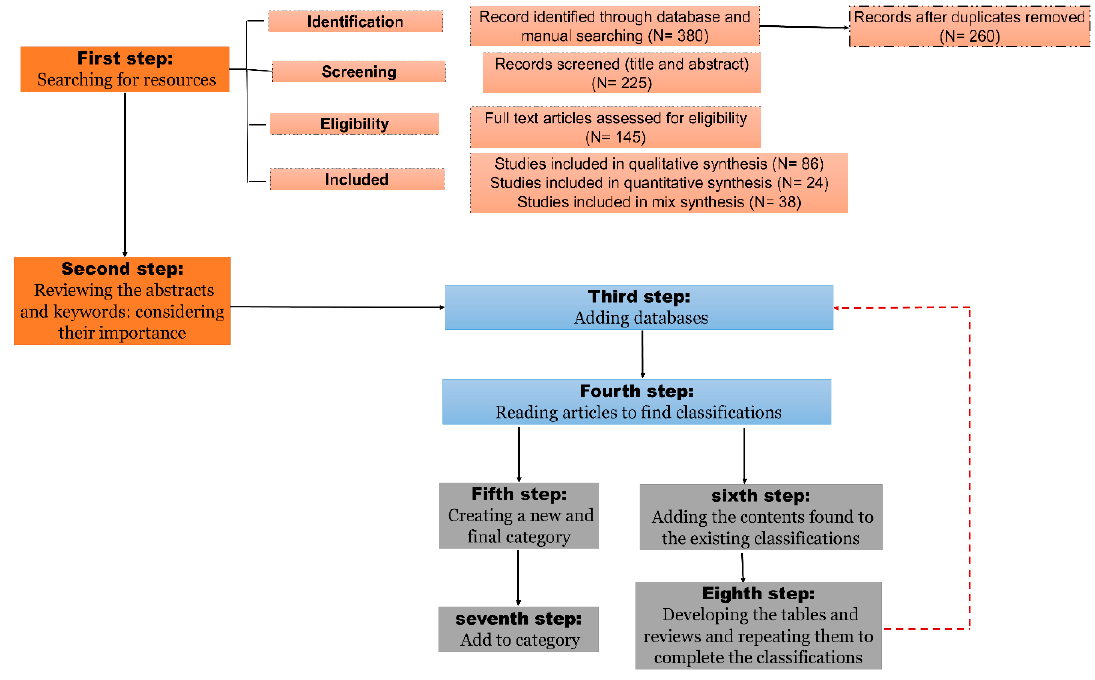
Figure 1. Flowchart of the research methodology.